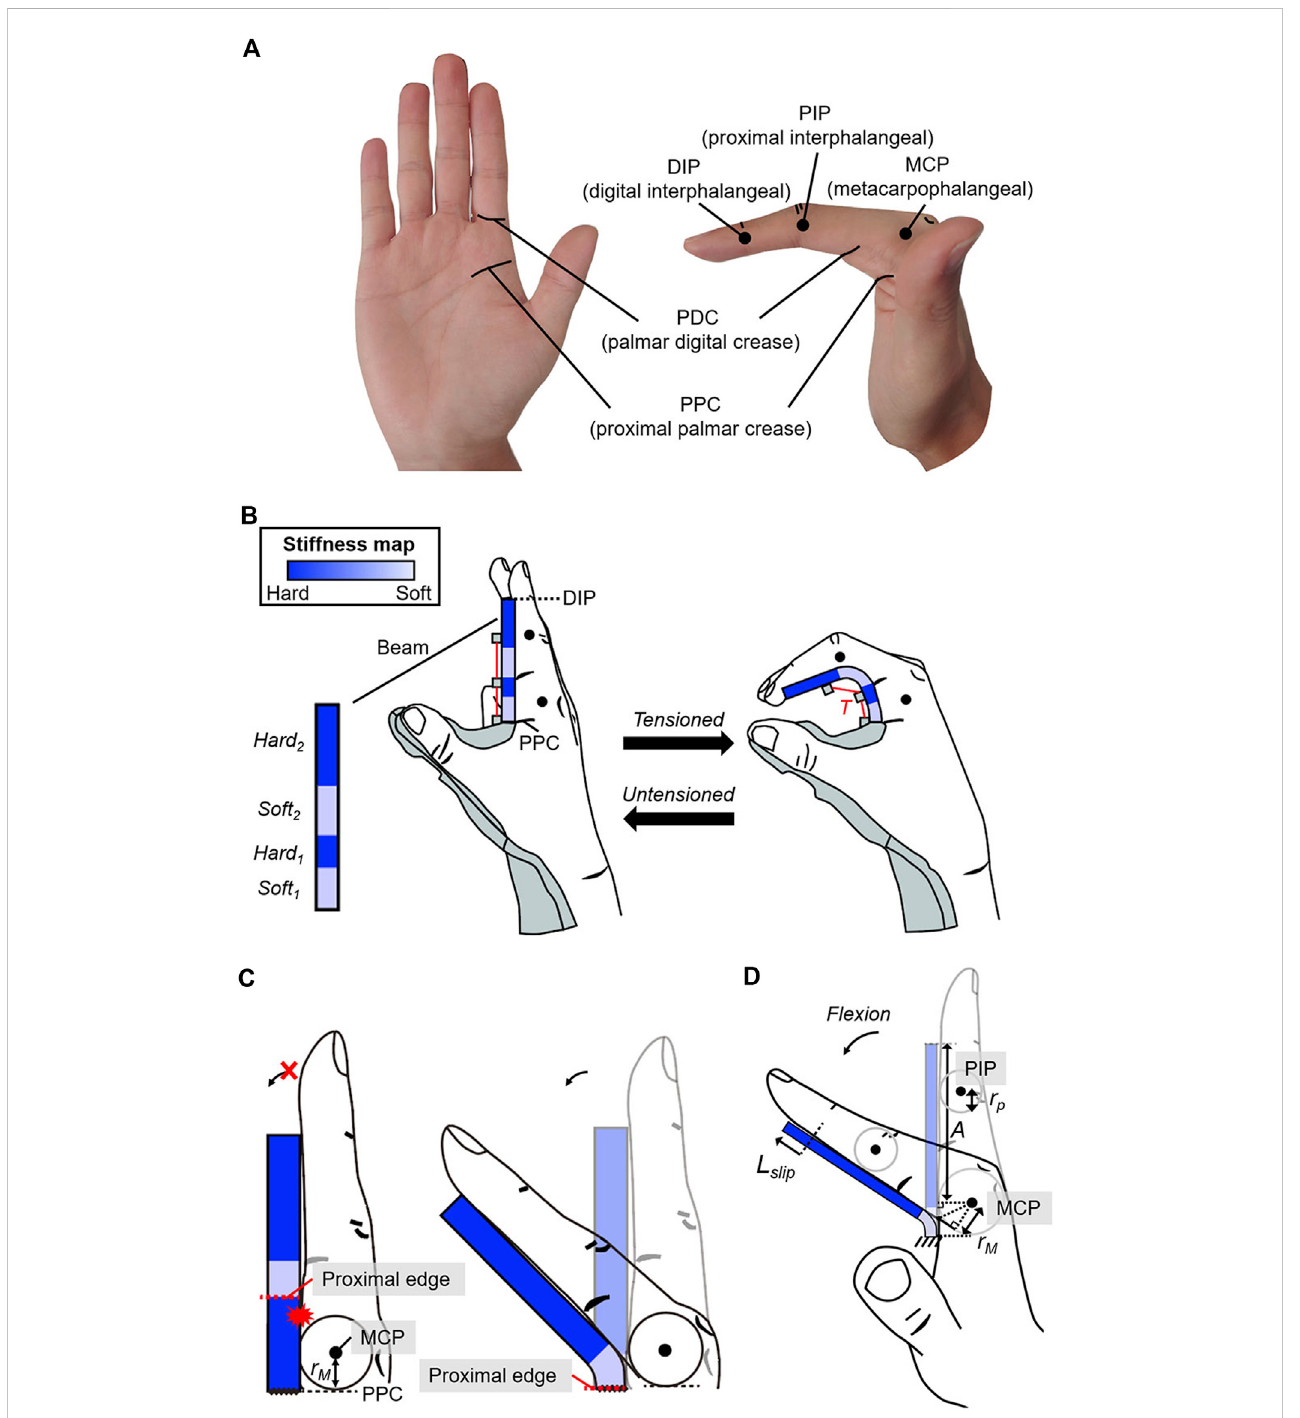
FIGURE 3 Geometric constraints of the beam to enable passive extension and active fl exion of the fi ngers. (A) Hand landmarks used to design the beam. (B) The beam covers the palmar aspect from the PPC to the DIP to enable passive extension of theMCP and PIP joints. The stiffness near the MCP and PIP joints is set lower than that in other regions to allow active fl exion of the joints under the assistive force ( T ). (C) The proximal edge of the soft region is set more proximal than the joint by a length greater than the radius of the joint to allow joint fl exion. (D) Slip distance ( L slip ) considered for locating Soft 2 . A is the length between the MCP and DIP joints. r M and r P are respectively the radius of the MCP and PIP